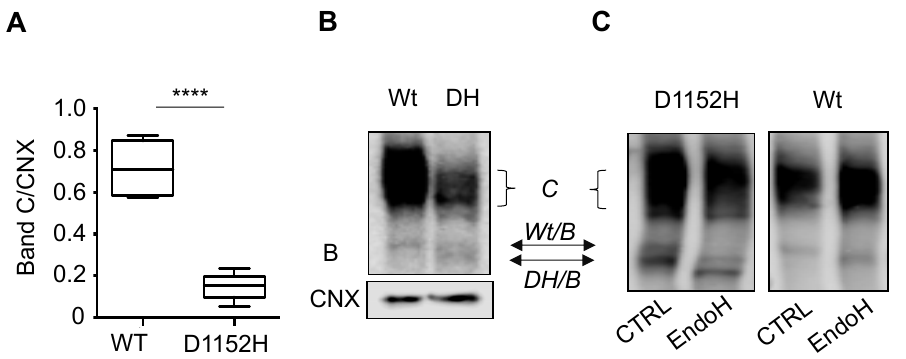
Figure 2. Nasal epithelial cells derived from one patient homozygous for the D1152H mutation exhibit protein processing defects. ( A ) Bar graphs represent the mean ( ± SD) of the CFTR protein expression in nasalcellsfromhealthycontrol(WT)comparedtoourD1152H / D1152HpatientasratiobandCtocalnexin C / CNX from 5 independent experiments. ( B ) Representative immunoblot from nasal cells generated from a healthy control (WT) and the D1152H / D1152H patient. C: mature, complex-glycosylated CFTR; B: immature, core-glycosylated CFTR. ( C ) Immunoblot shows the sensitivity of band B of the D1152H-CFTR in nasal epithelial cultures to endoglycosidase H (EndoH). (**** p <